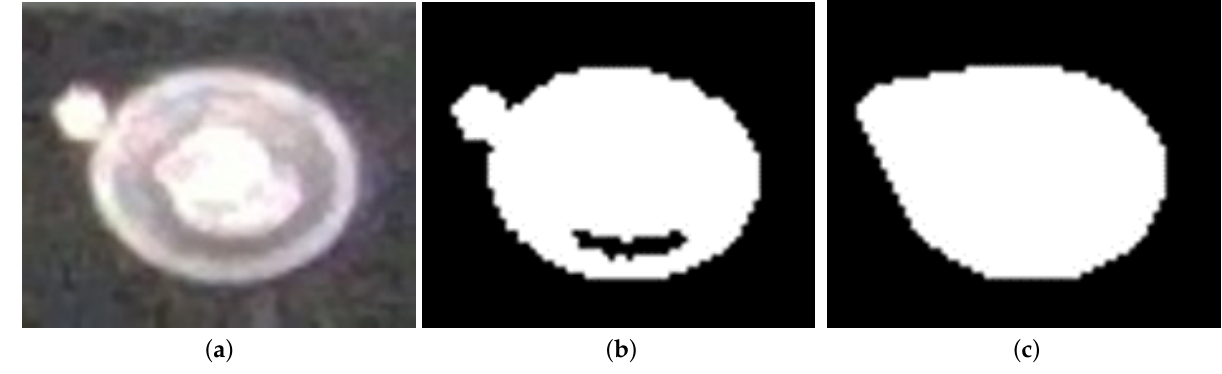
Figure 16. OTSU-based binary thresholding process: ( a ) RGB original image after relaxed crop out; ( b ) binary image after OTSU-based binary thresholding; ( c ) binary image after convex wrapping of what is considered to be the screw part (white area), and the black part is considered to be the background.